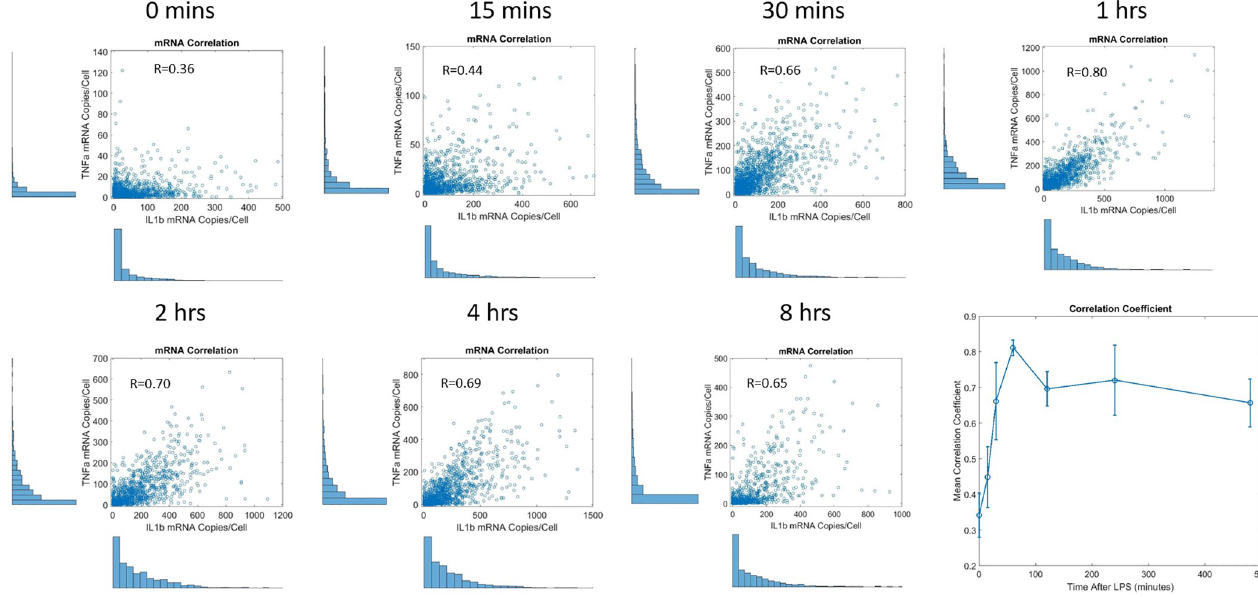
Fig 6. Scatter plots of IL1 β -TNF- α mRNA correlation at the single-cell level. Each dot represents a single-cell). Without stimulation, the genes are weakly correlated. Correlation peaks at 1 hour when both of these inflammation genes are highly active. https://doi.org/10.1371/journal.pone.0215602.g006 relation between the genes. As expected, the first sign of gene expression for both IL1 β and TNF- α is visible at the intron bursting sites located in the cell nuclei, followed by subsequent expression as mature mRNA predominantly in the cytoplasm. Additionally, the correlations of mRNA-mRNA content at the single-cell level demonstrate that IL1 β and TNF- α are